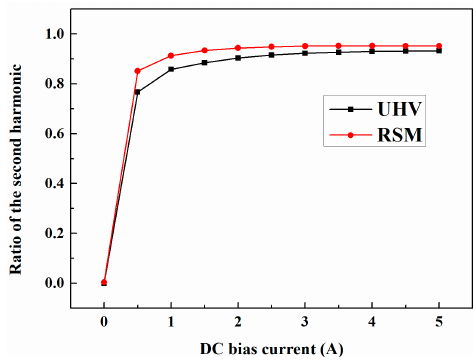
Appl. Sci. 2020 , 10 , x FOR PEER REVIEW Figure 7. Ratio of the second harmonic to the fundamental under DC bias of the UHV and RSM. Figure 7. Ratio of the second harmonic to the fundamental under DC bias of the UHV and RSM. Figure 7. Ratio of the second harmonic to the fundamental under DC bias of the UHV and RSM. Figure 7. Ratio of the second harmonic to the fundamental under DC bias of the UHV and RSM.